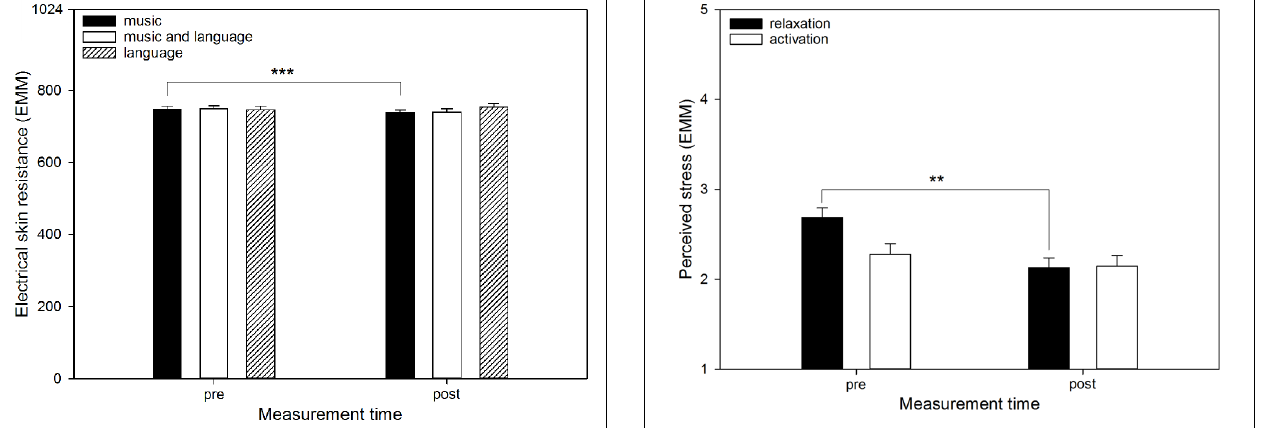
FIGURE 1 | Electrical skin resistance (ESR) by listening mode before and after using the app. The graph shows the estimated marginal means (EMM) of ESR before (pre) and after (post) using the app, separated by the three modes (“music,” “music and language” and “language”). Error bars represent standard errors of EMM. ∗∗∗ p < 0.001.